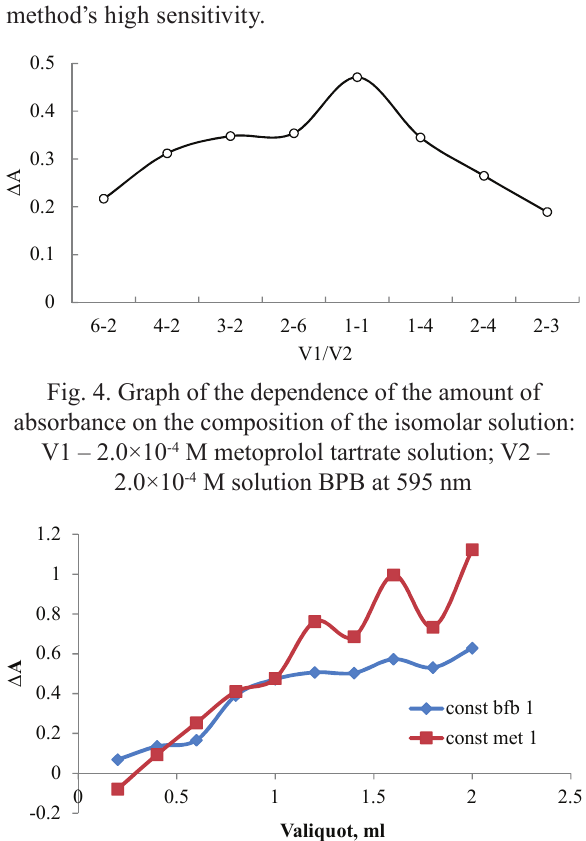
Fig. 5. Saturation curves: metoprolol tartrate solution at a constant concentration of reagent (1.00 mL of 2×10 -4 M solution), BPB solution at a constant concentration of metoprolol tartrate (1.00 mL of 2×10 -4 M